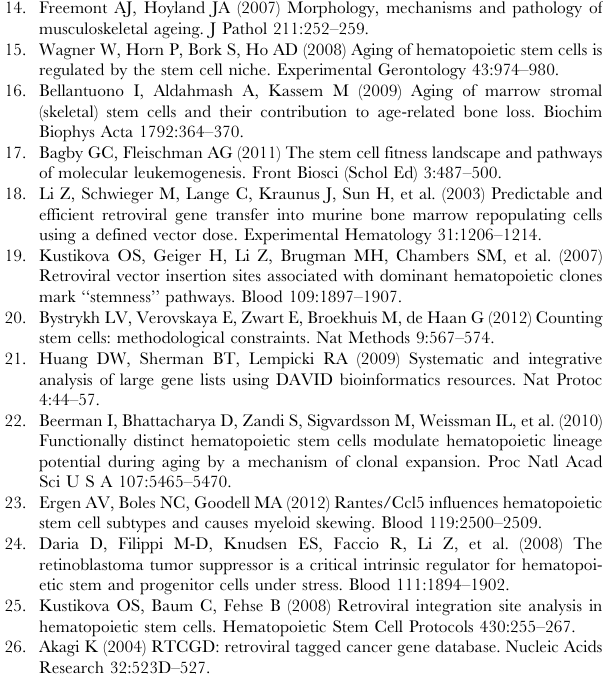
Table S1 Detailed list of integration sites isolated from young (A) and aged (B) recipient mice after 24–26 weeks of transplantation. The genomic locations of RISs and the nearest neighboring genes within 100 kb are listed. The RISs isolated from to the same recipient were grouped together to show that more RISs were recovered from young mice with oligoclonal GFP + population and less insertion sites from the monoclonal GFP + population of the aged recipients. Figure 2/D was created based on sequencing results in combination with LM-PCR band patterns. The range of integrations per clone was calculated. The RIS/cell ranged from 1 to 4). The listed RISs were compared with two databases (Retroviral Tagged Cancer Gene Database (RTCGD), Insertional Dominance Database (IDDb)) to strength- en the validity of the applied methods. Within the RTCGD, retroviral integration sites associated with candidate cancer genes have been collected (ref. 22 ). The IDDb listed RISs related to dominant clone formation (ref. 23 ). Overall, 27.9% of the recovered RISs from young mice and 27.2% from old were found in the RTCGD, and 3 genes from young recipients and 1 gene